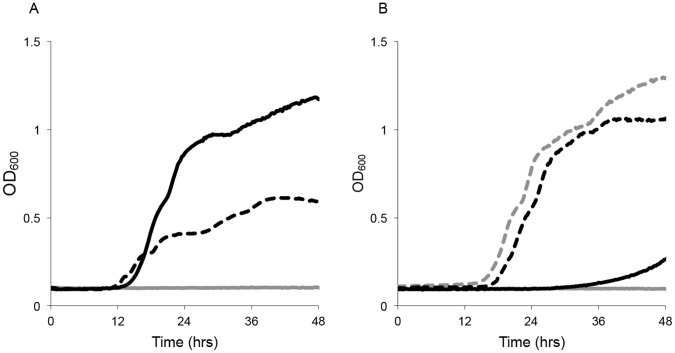
AHLs upregulate the maltose operon and enhance growth on maltose.(A) Growth of wild-type (WT) (black), and AHL mutant (dashed) Y. pestis in minimal maltose medium (light grey) was monitored in Bioscreen C microplate reader incubating at 28°C with agitation. (B) Complementation of AHL mutant bacteria with pypeIR (black, dashed) or pyspIR (grey, dashed) restores growth on maltose, whereas control plasmid (black, solid) does not.